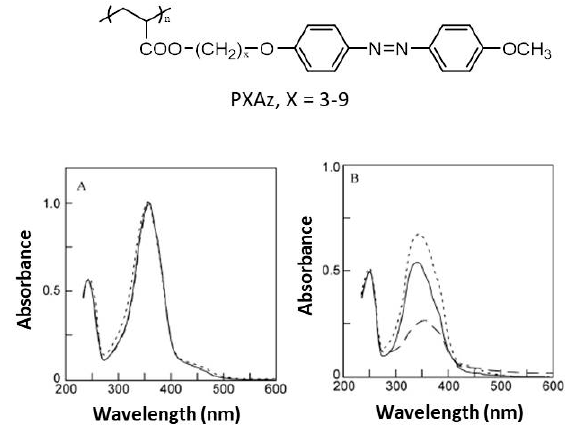
Figure 7. Schematic molecular structure ofthe azo-functionalized liquid crystal polymer with the different methylene spacer length (PXAz, X is the methylene spacer length, 3 to 9) and the absorption spectra of PXAz (X = 3, 6, 8) in chloroform solution ( A ) and film ( B ). Source: Yagi et al. 2014 [42]. Copyright 2014. Reprinted with permission from Elsevier Ltd.